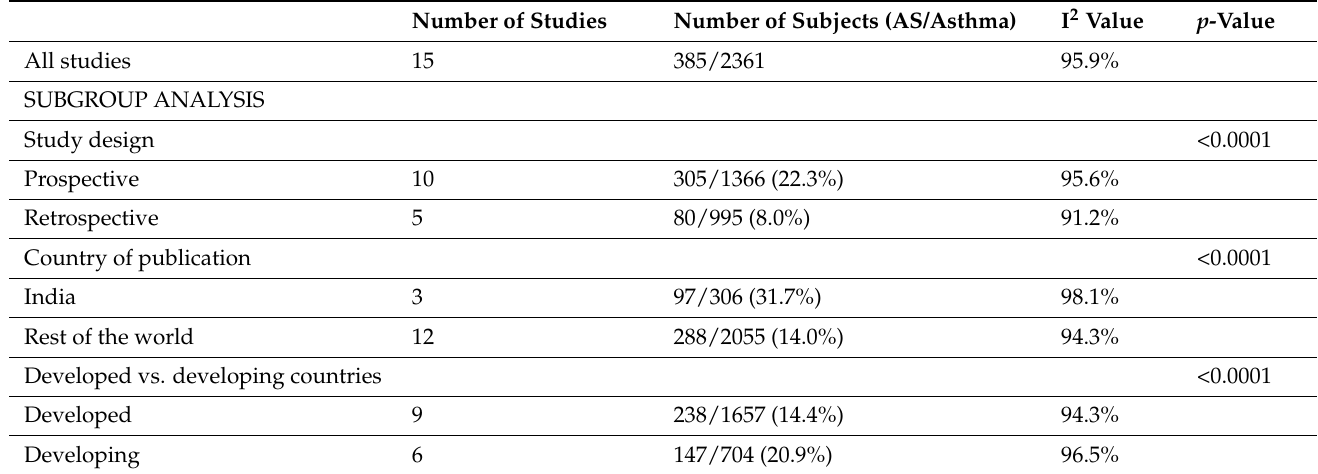
Table 2. Prevalence of aspergillus sensitization (AS) in various subgroups of asthmatic children.